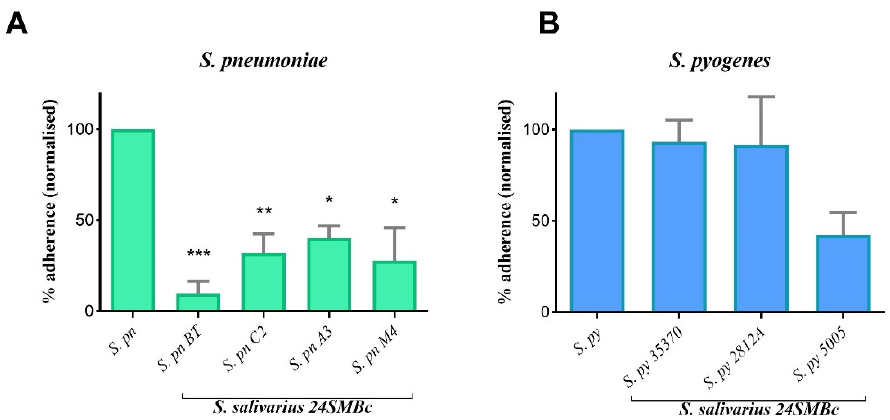
Figure 3. Antagonistic effect of S. salivarius 24SMBc against streptococcal pathogens. ( A ) Adherence percentage of S. pneumoniae BT ( S. pn BT), S. pneumoniae C2 ( S. pn C2), S. pneumoniae A3 ( S. pn A3), and S. pneumoniae M4 (S. pn M4) normalized to S. pneumoniae alone ( S. pn ). ( B ) Adherence percentage of S. pyogenes Spy3537 ( S. py 35370), S. pyogenes 2812A ( S. py 2812A), and S. pyogenes MGAS 5005 (